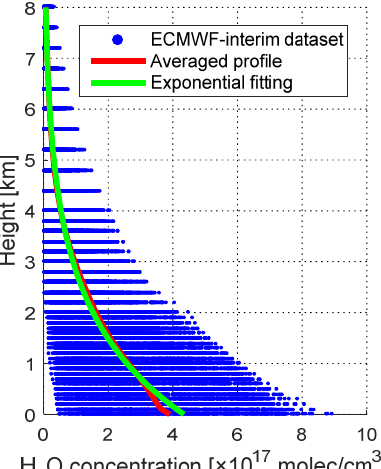
Figure 3. Determination of a priori profiles in Heidelberg Profile Retrieval (HEIPRO) using European Centre for Medium-range Weather Forecasts (ECMWF) ERA-interim reanalysis datasets. The blue points represent interpolated water vapor profiles from the ECMWF ERA-interim datasets between 12 April and 30 September 2018. The red and green lines represent the averaged ECMWF ERA-interim profile and exponential fitting profile, respectively.